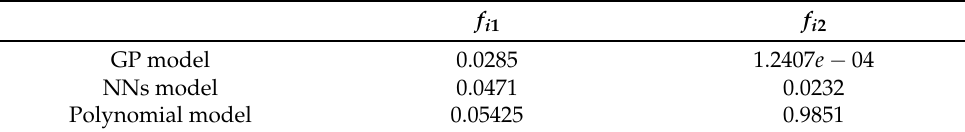
Table 1. The RMSE of three models.